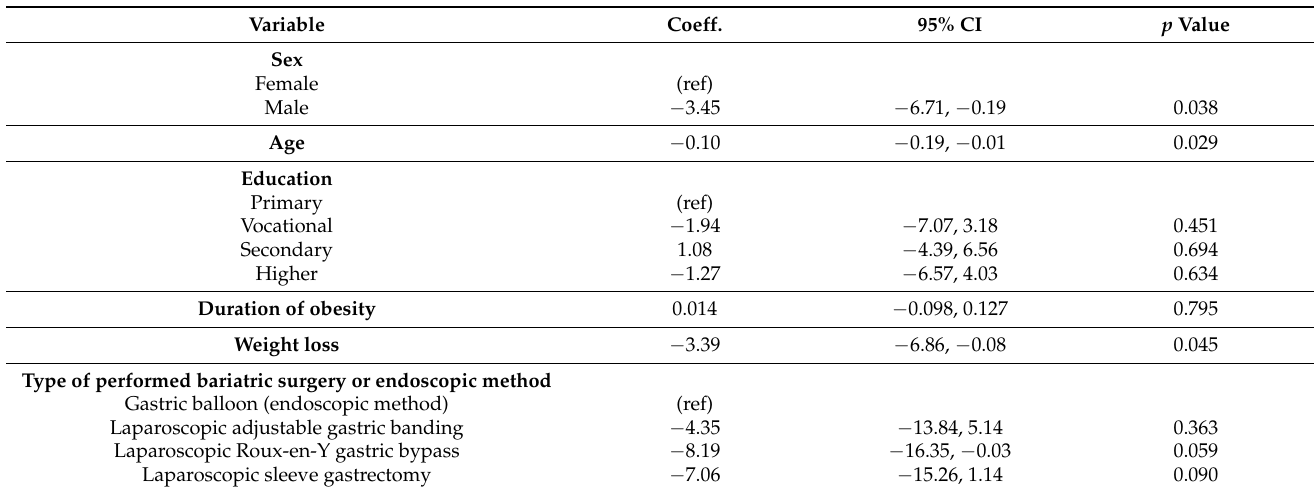
Table 3. Multiple regression analysis for the level of patient’s discrimination due to prevalence of obesity in Poland and Germany ( n =